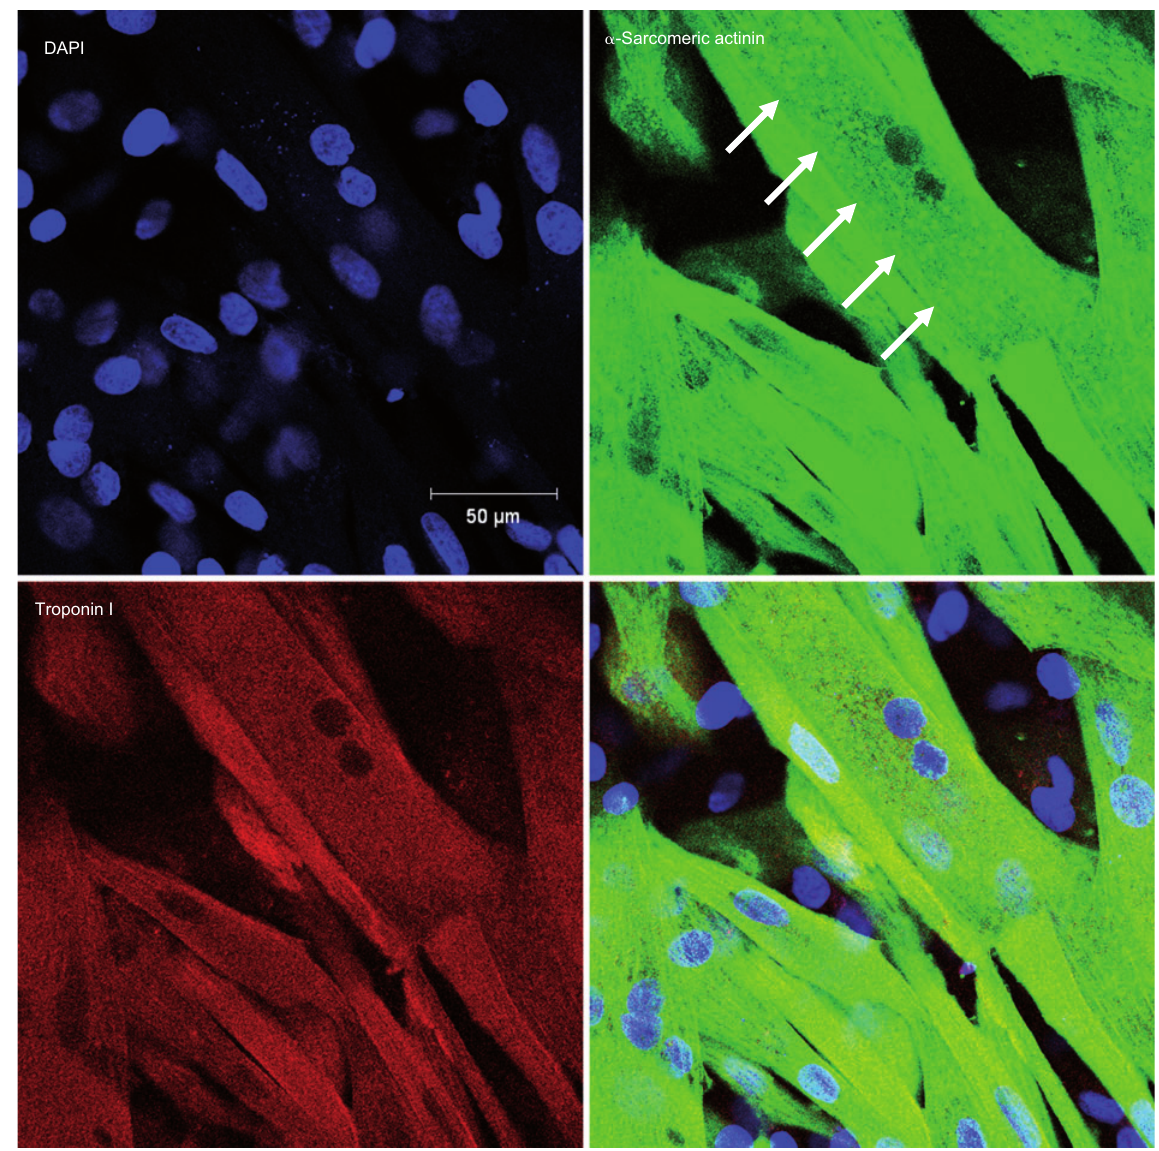
Figure 3 Noggin could induce many mature cardiac myocytes. LA-PCs were cultured in MethoCult medium with noggin. The differentiated cells were stained with cardiac myocyte marker, troponin I, and α -sarcomeric actinin. Figure reproduced from reference (49) with